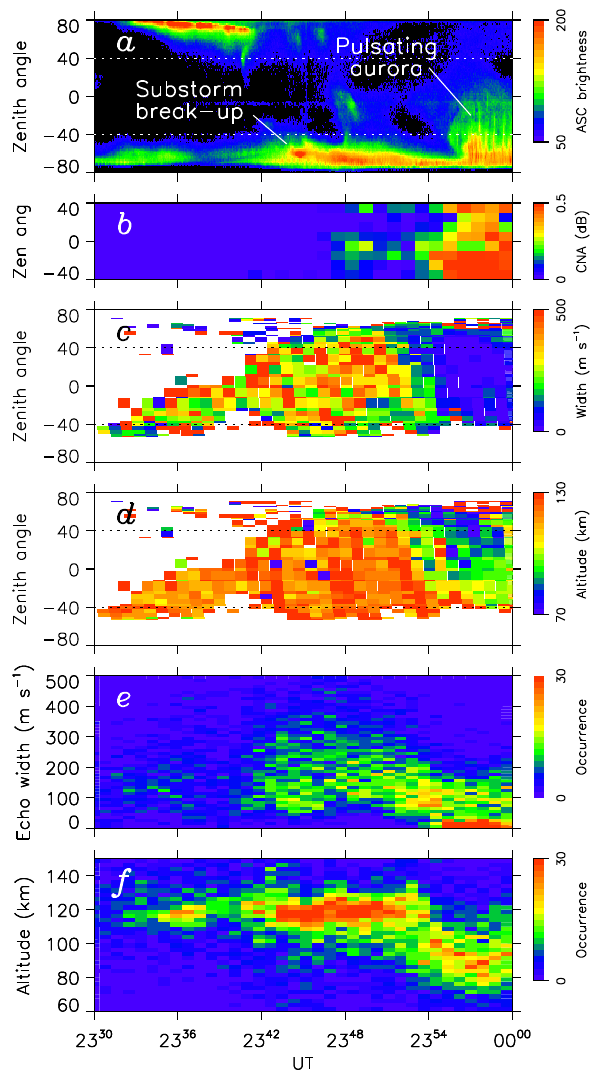
Fig. 2. (a) Keogram of the auroral observations from the geo- magnetic meridian of the ASC field-of-view, between 23:30 and 24:00UT on the 13 September 1999. (b) Cosmic noise absorp- tion along the same geomagnetic meridian. (c) Radar observations of radar echo width, projected along the ASC meridian. (d) Esti- mate of the altitude of the backscatter volume, projected along the ASC meridian. (e) Temporal evolution of the distribution of spec- tral widths of the radar echoes observed. (f) Corresponding altitude